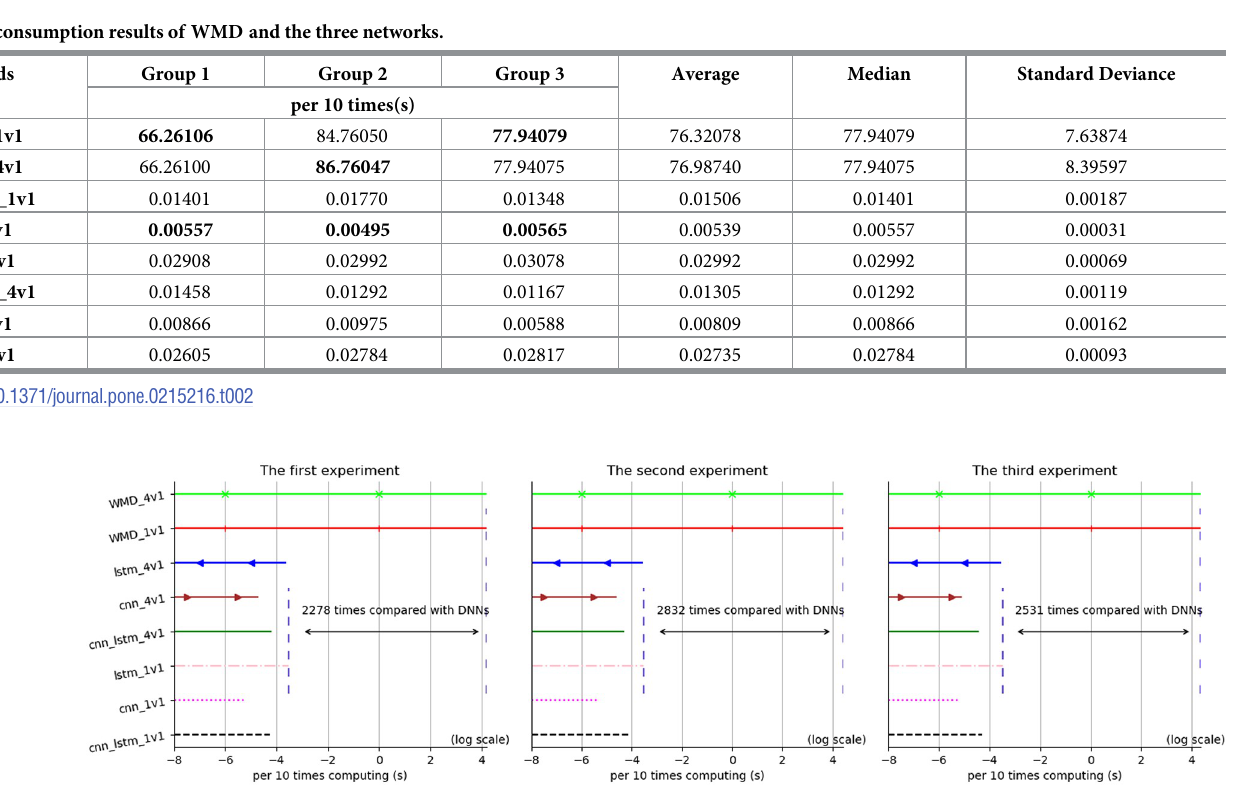
Fig 6. Acceleration results among WMD and the three